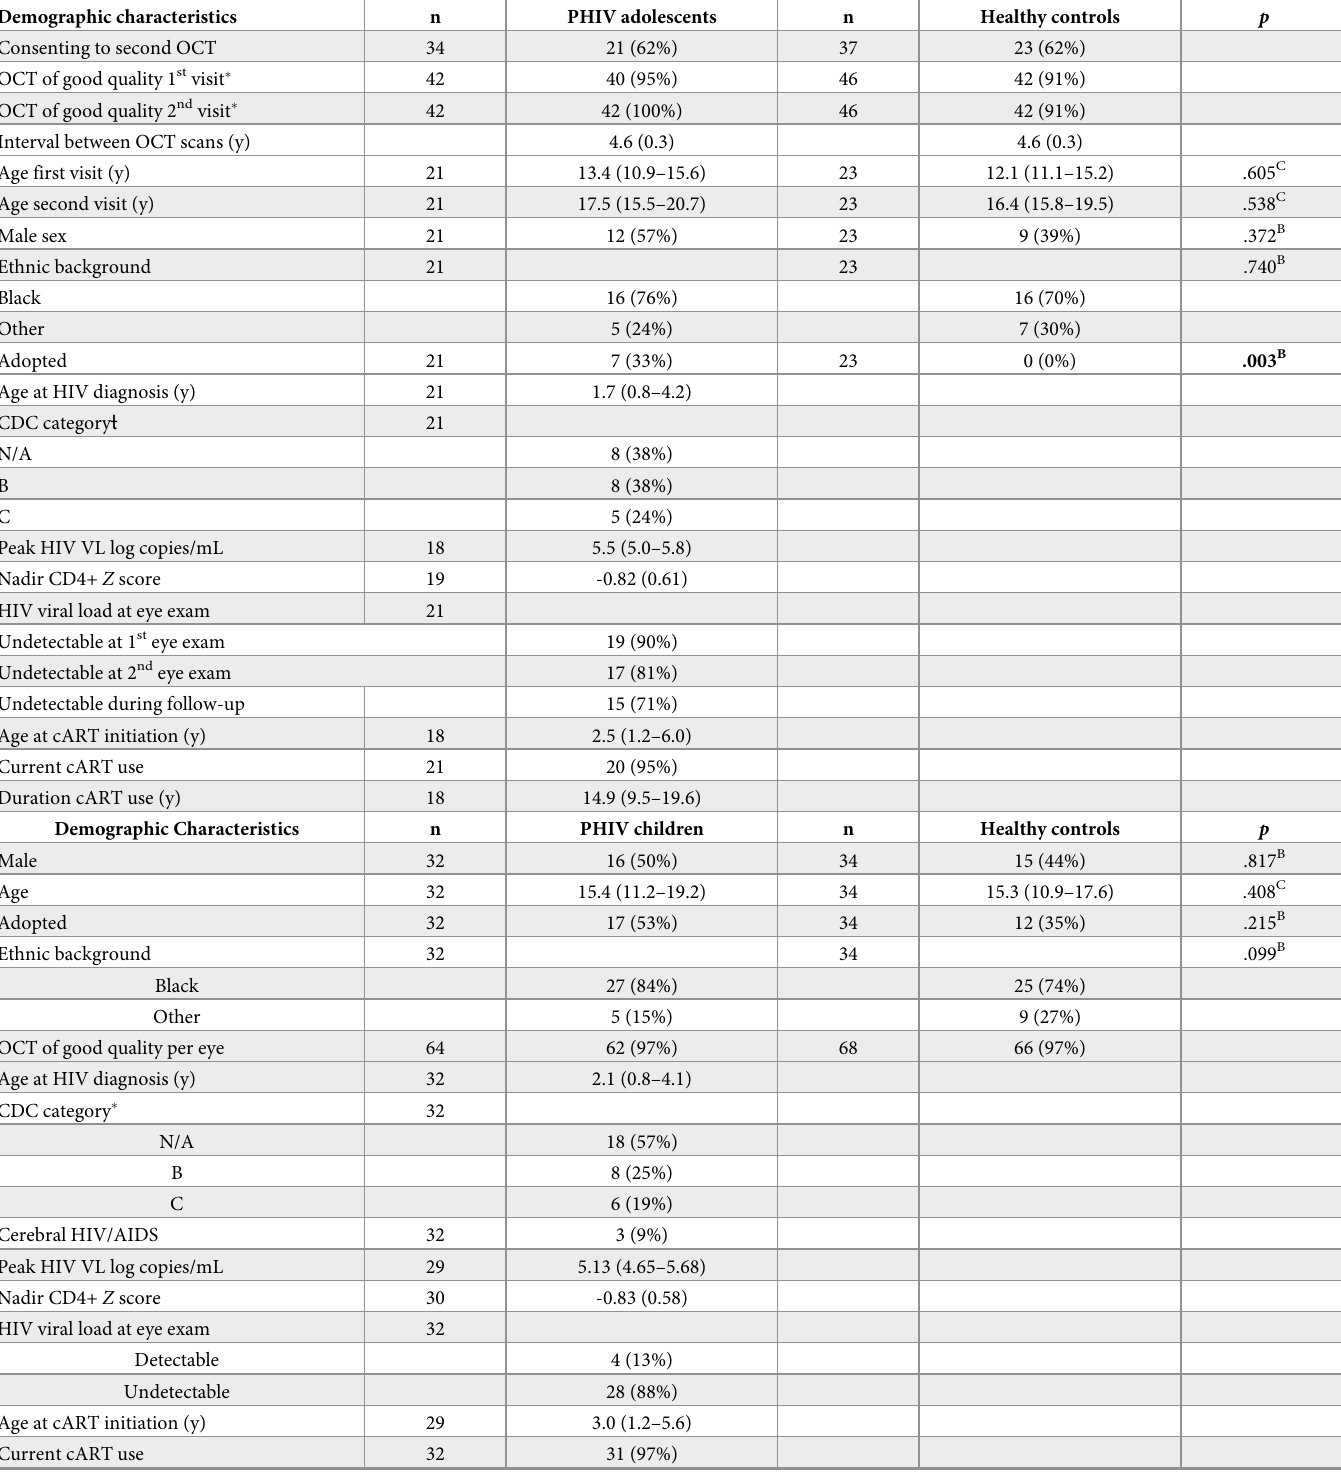
Table 1. a. Participants’ Characteristics at 2 nd enrollment of the longitudinal substudy. b. Participants’ characteristics of the cross-sectional